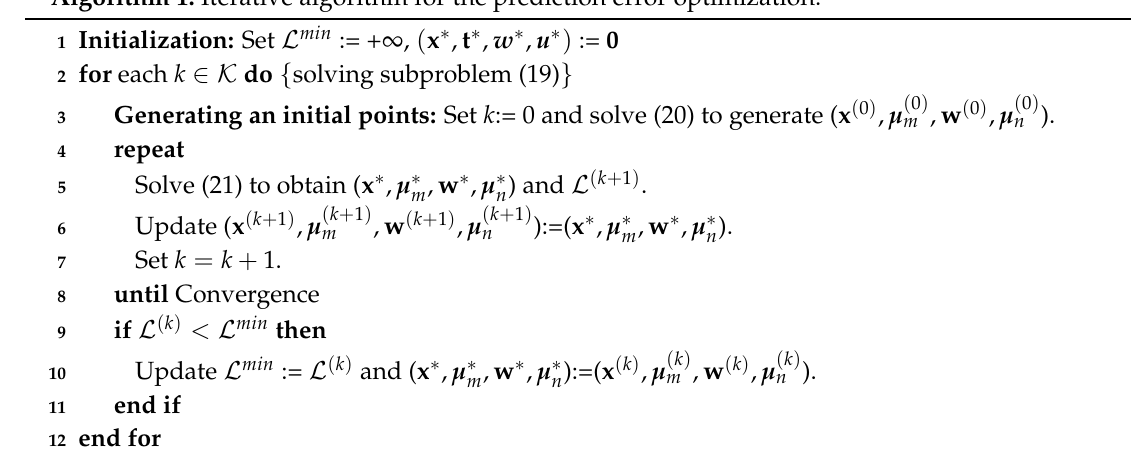
Algorithm 1: Iterative algorithm for the prediction error